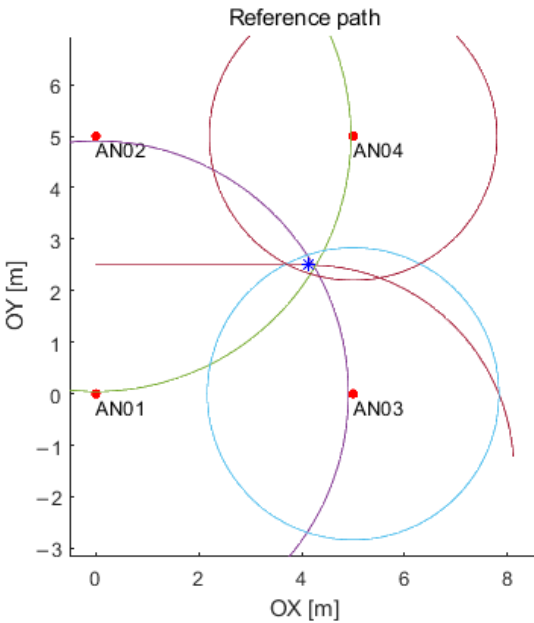
Figure 19. Example of the distance simulation for a single point (i.e., a tag, blue asterisk) on the path.